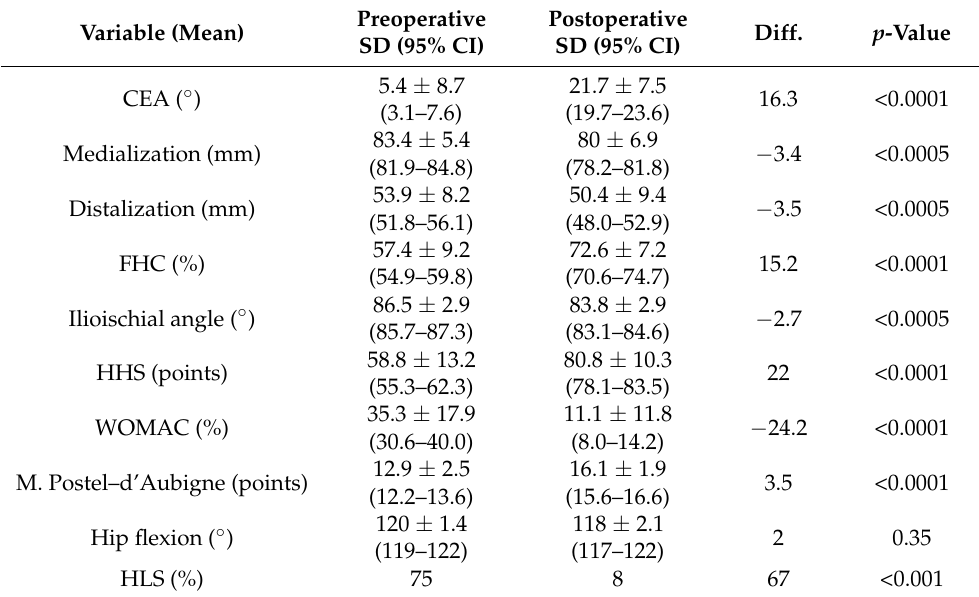
Figure 3. ( a – c ) Radiographic measurements of CEA (10°), FHC (52%), and K ilioischial angle (87°) preoperatively; ( d – f ) radiographic measurements of CEA (28°), FHC (80%), and K ilioischial angle (82°) postoperatively. Linear correlation analysis revealed a statistically significant Pearson correlation between the CEA and ilioischial angle (r = − 0.527) (Figure 4) and the FHC and ilioischial angle (r = − 0.511) (Figure 5). Based on the crossover sign on the AP digital radiogram of the hip joints, we did not observe acetabular retroversion after PAO in any of the patients.